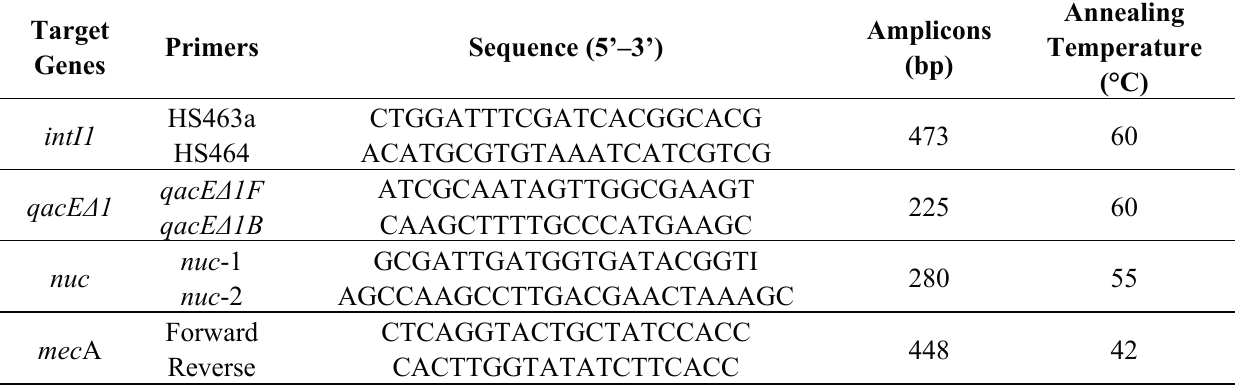
Table 1. Primers used in this